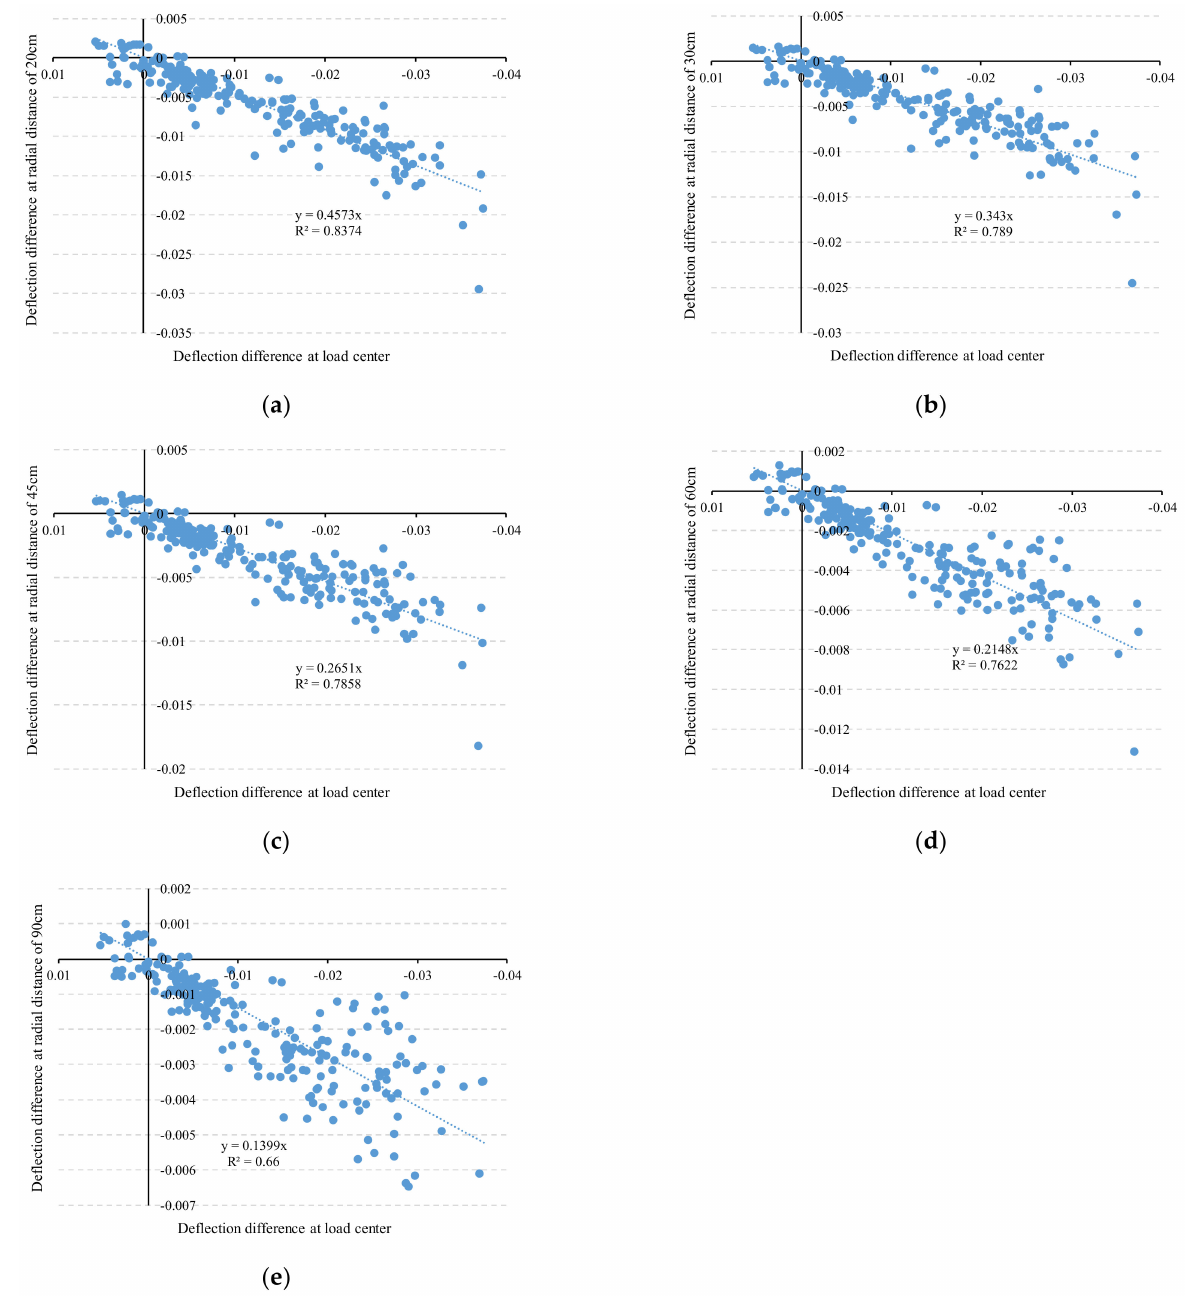
Figure 8. Fitting results between deflection difference at different radial distances and load center deflection difference: ( a ) 20 cm; ( b ) 30 cm; ( c ) 45 cm; ( d ) 60 cm; ( e ) 90